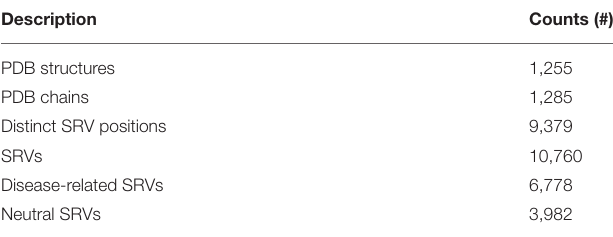
TABLE 1 | Statistics of HVAR3D 2.0 dataset.